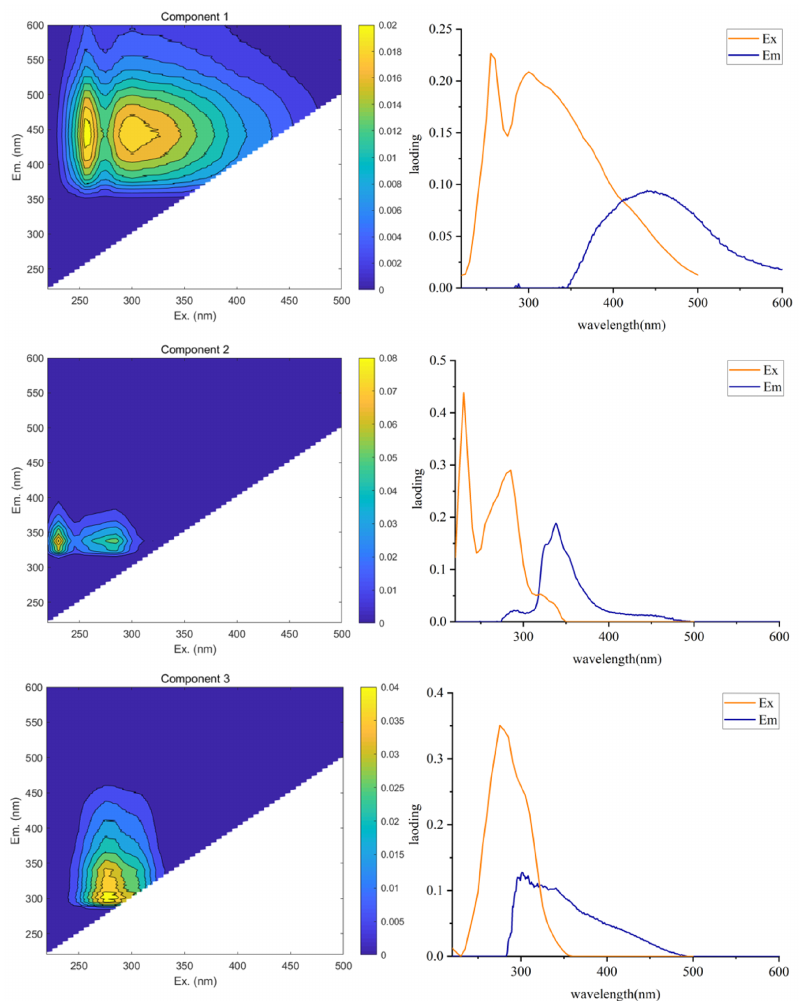
Figure 5. Spectral shapes of the three components of drip water from Daxiao